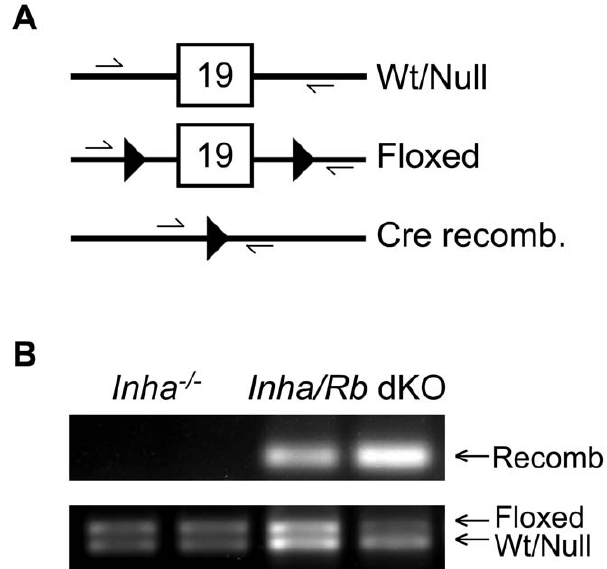
Figure 1. Proof of Rb recombination in testes of 6 week-old mice. PCR amplification of the region surrounding exon 19